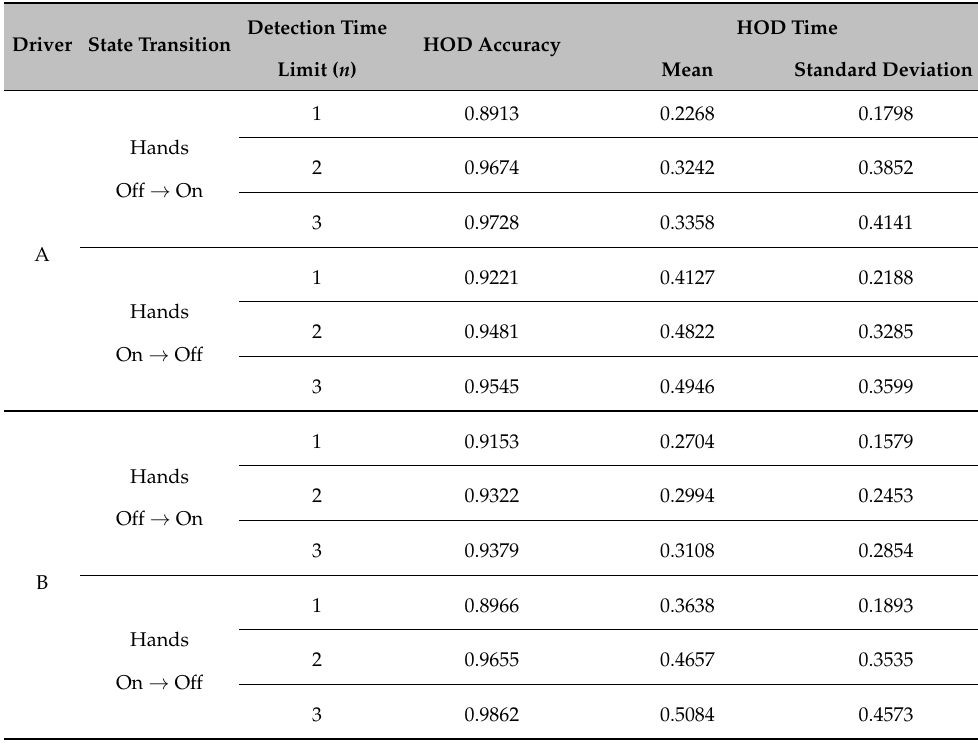
Table 11. HOD accuracy and time considering state transition on the new driver data (time window size = 10). The unit of detection time limit and HOD time is